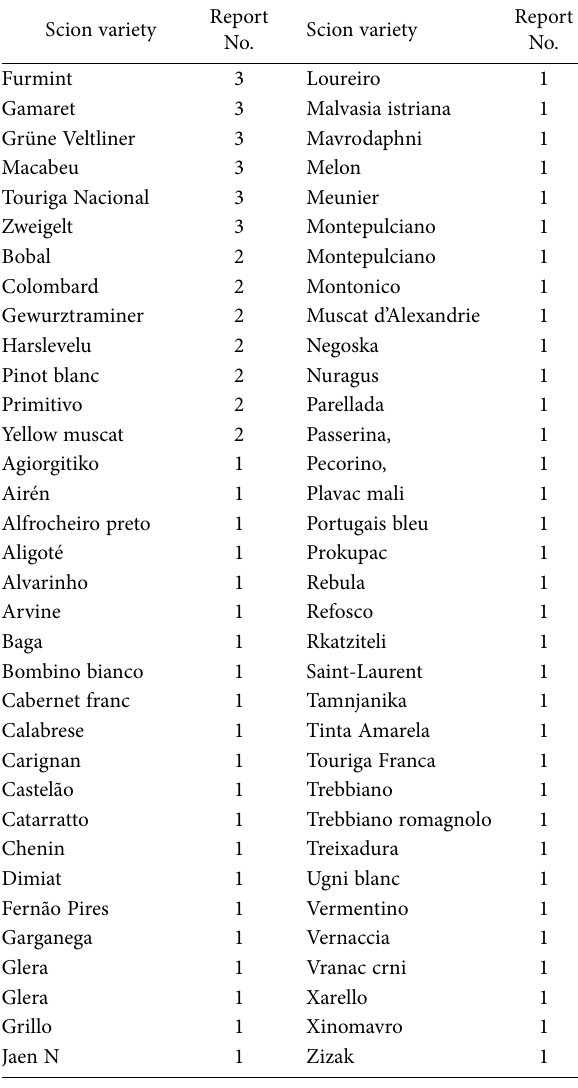
Figure 1. Numbers of reports of the main scion cultivars recorded in 105 surveyed regions. Table 3. Grapevine scion varieties infrequently identified in survey questionnaire responses, with one to three mentions.